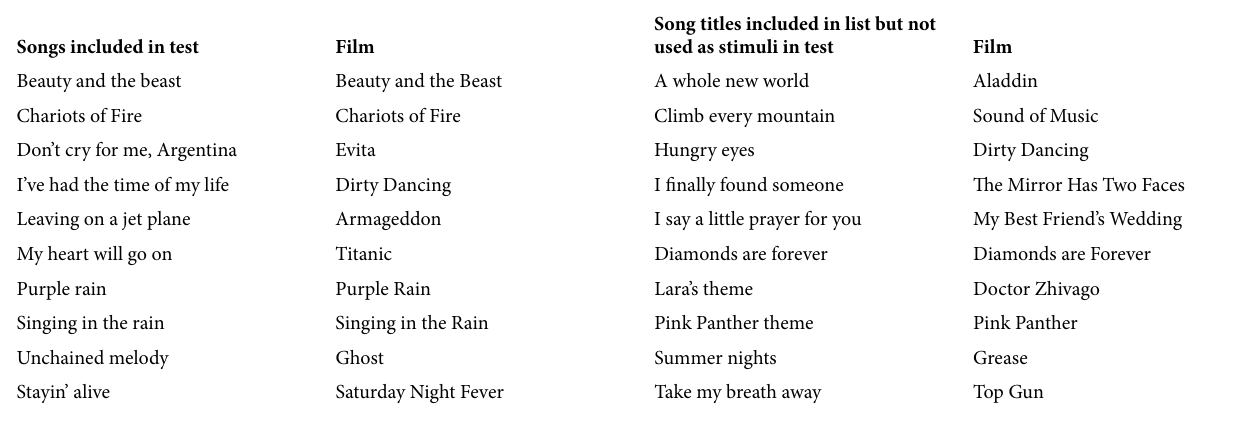
Table IV. Songs included in the music-in-noise song identification test (sub-test 11) Songs included in